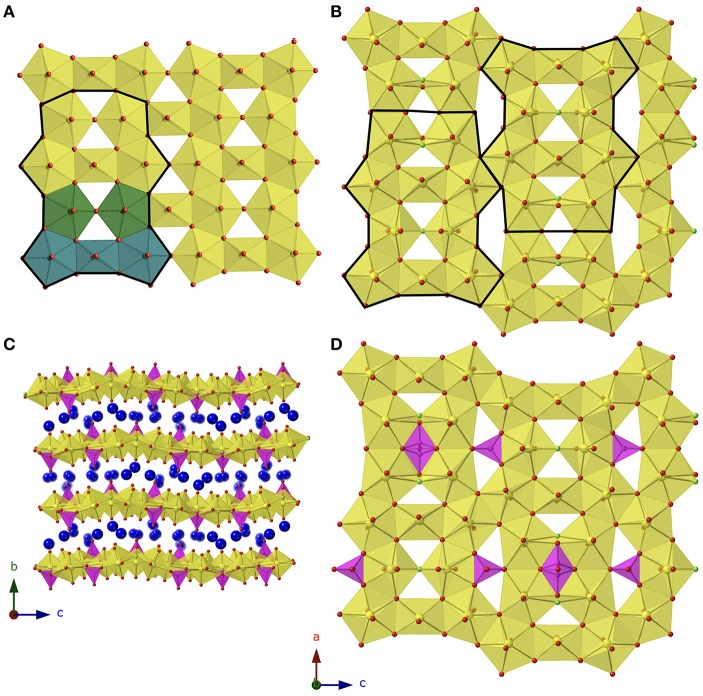
(A) β-U3O8 topology with building unit outlined in black and U3O16 and U2O14 units shown in blue and green, respectively. (B) Topology of 1 and 2 with the building unit boldened, and the phosphate tetrahedra omitted. (C) View of 1 in the a direction. (D) The sheets found in 2 with phosphate tetrahedra included. Uranium, phosphorus, oxygen, and alkali cations are shown in yellow, magenta, red, and blue, respectively.